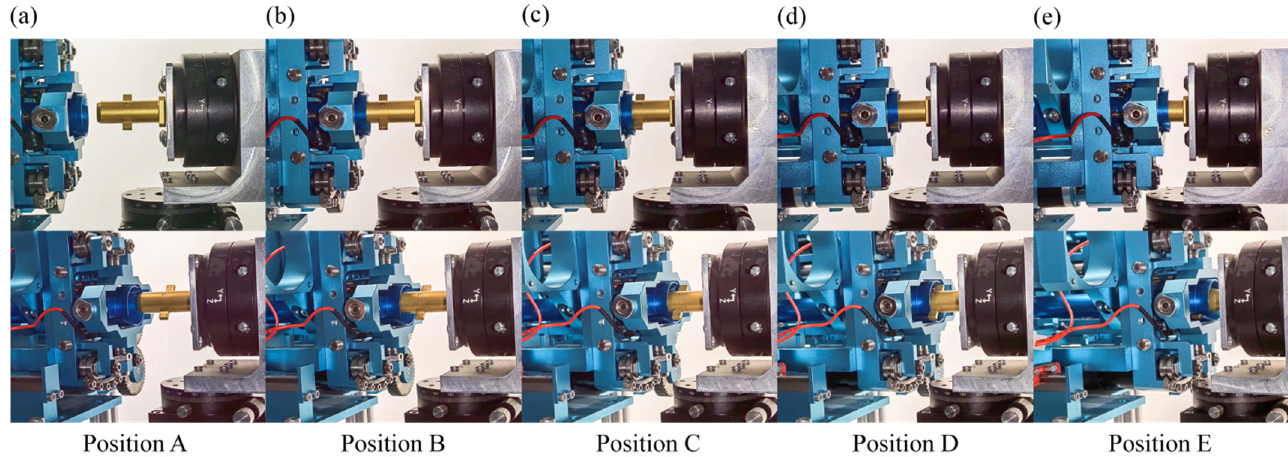
Figure 22. Key positions of the docking: ( a ) Position A—Initial, ( b ) Position B—Contact and align- ment I, ( c ) Position C—Probe insertion and alignment II, ( d ) Position D—Pin insertion and